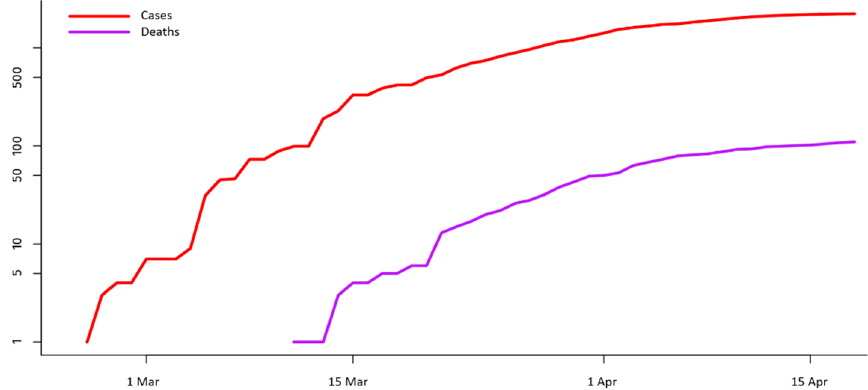
Figure 4. Comparative diagram with the time ‐ series of the COVID ‐ 19 infection cases versus the recorded deaths in Greece (data source: [27]).